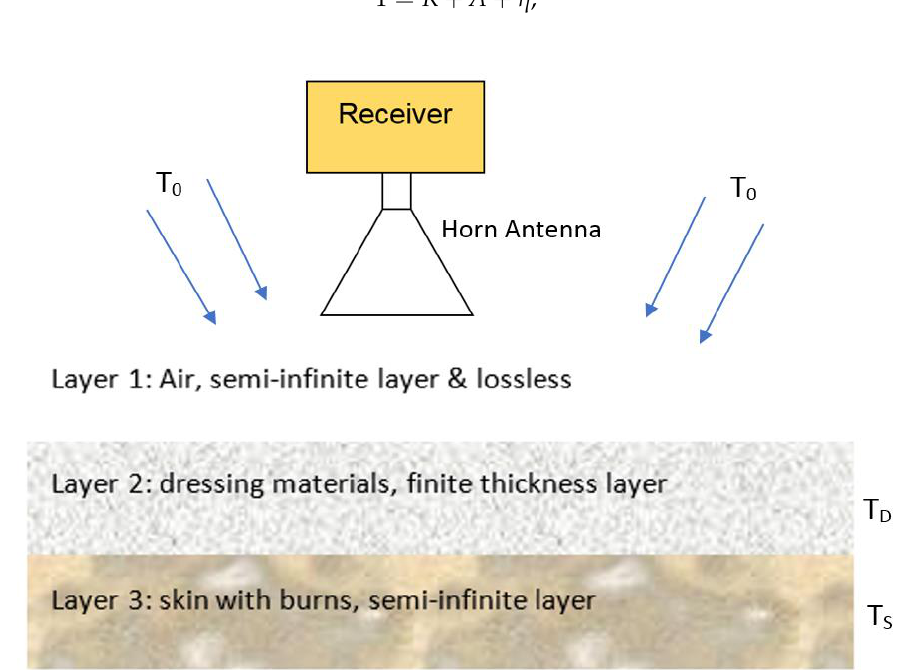
Figure 2. Three-layer model for dressed burn wound comprising of: a semi-infinite layer of air, finite thickness layer of dressing materials, and a semi-infinite layer of burn-damaged skin.